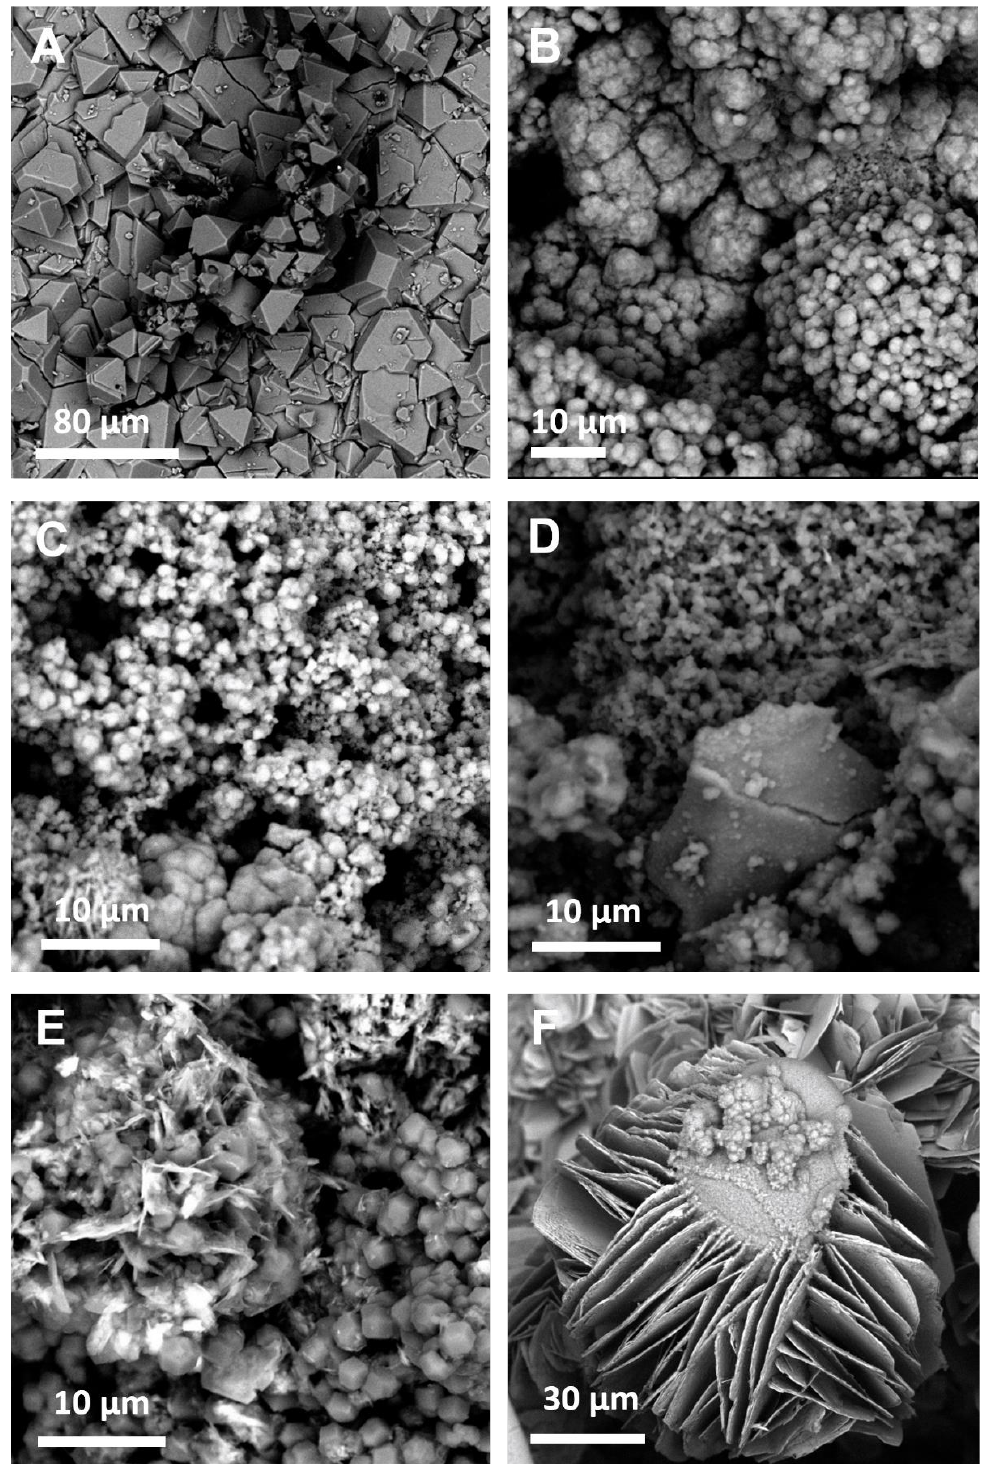
Figure A2. SEM images of the MOF coatings obtained using traditional solvents demonstrating the expected morphologies for: ( A ) HKUST-1; ( B ) ZIF-8; ( C ) ZIF-7; ( D ) ZIF-67; ( E ) ZIF-14; ( F ) ZIF-zni.